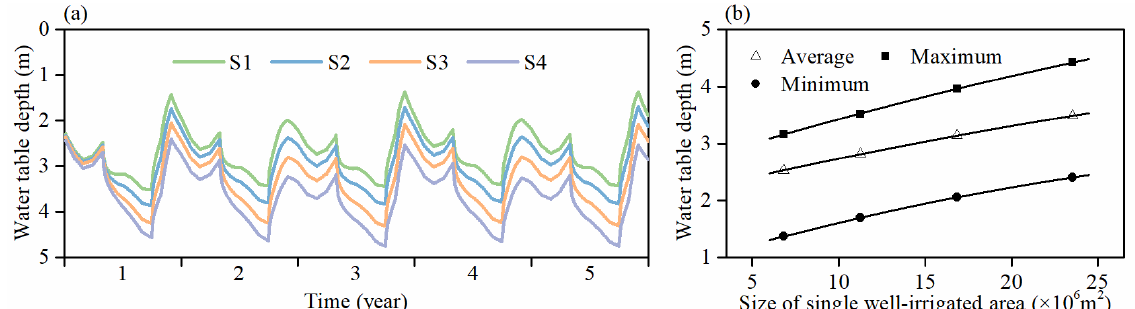
Figure 8. Predicted water table depth under the 4 scenarios with different size of single well-irrigated area, ( a ) the spatial average water table depth under the 4 scenarios in the future 5 years, and ( b ) the relationship between the water table depth and the size of single well-irrigated area.